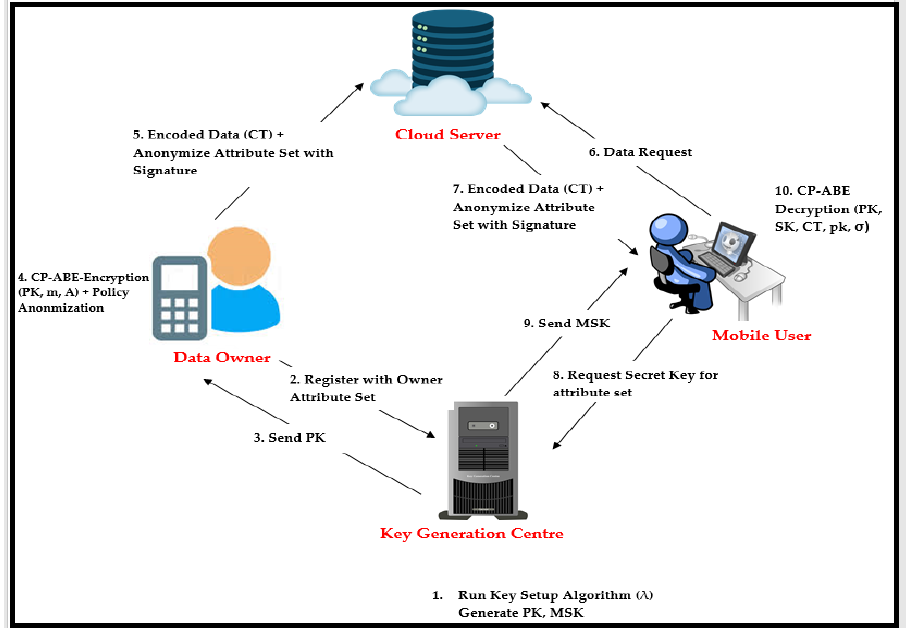
Figure 3. A system model of our proposed CP-ABE scheme.